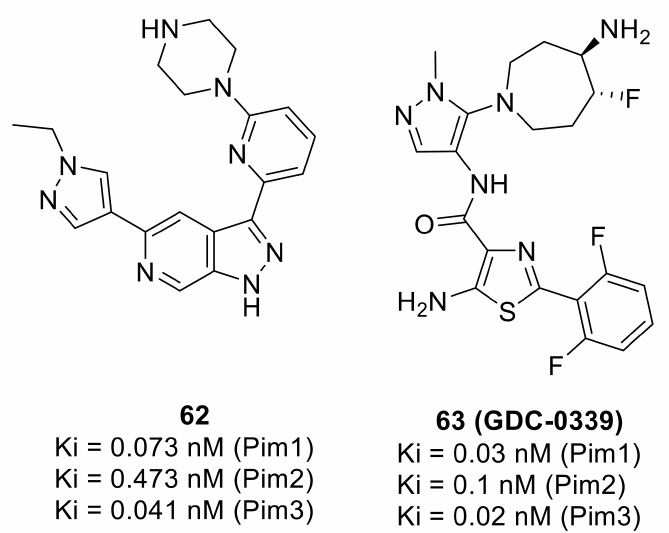
Figure 68. Structures of pyrazole-based Pim kinase inhibitors and their Ki